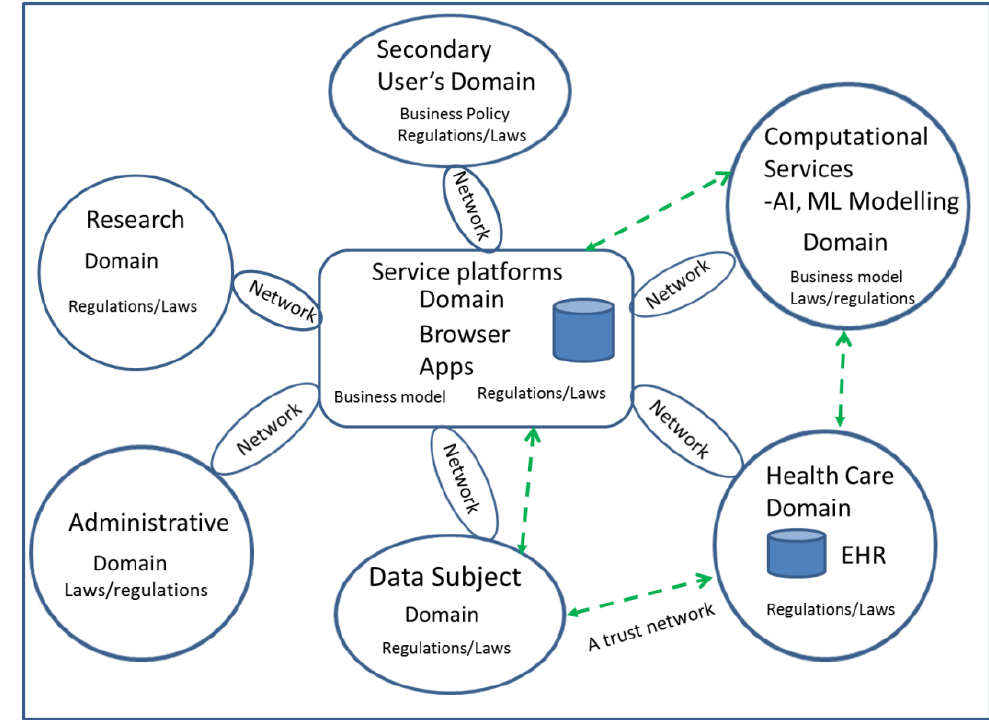
Figure 2. A conceptual model of the eHealth ecosystem.